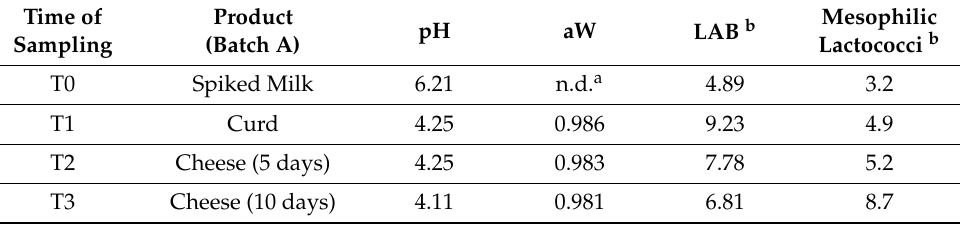
Table 2. Microbiological and physicochemical parameters during the cheese manufacturing process for Batch A.